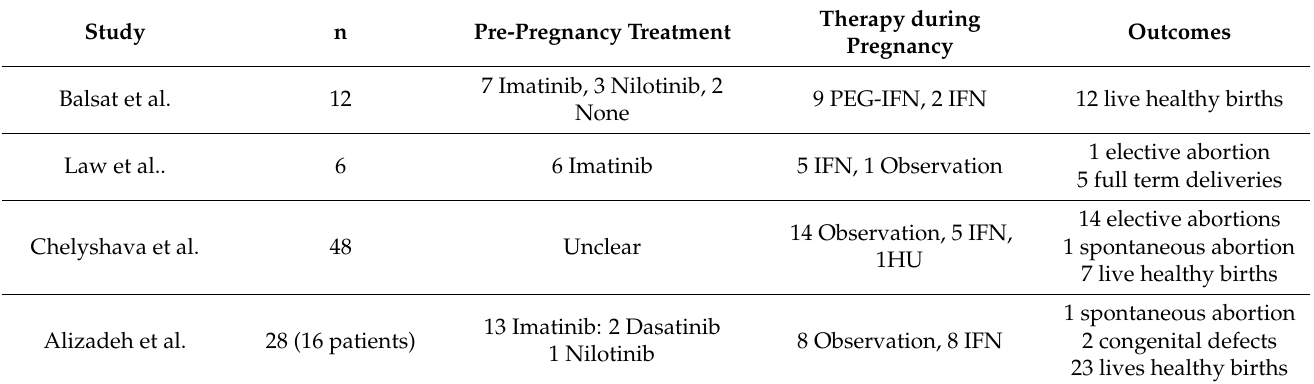
Table 2. CML management during pregnancy after TKI